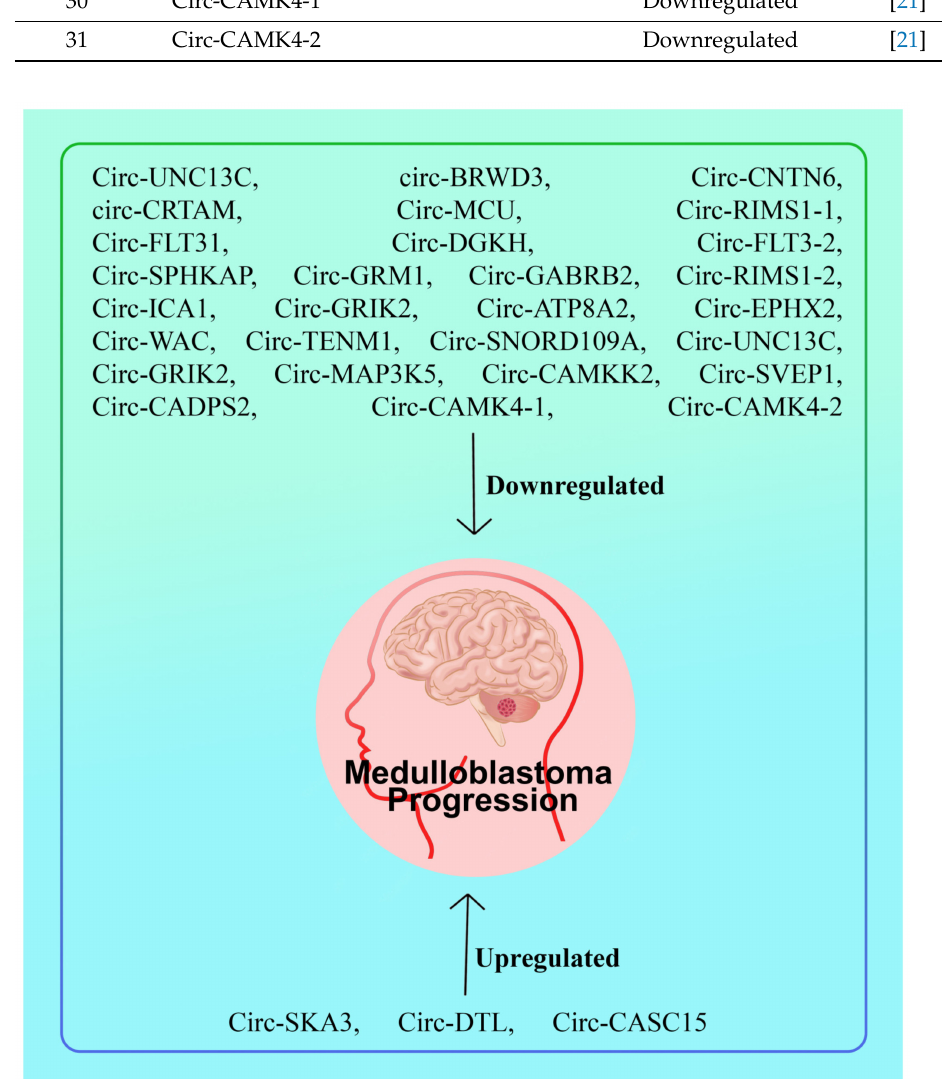
Figure 2. CircRNA regulation on medulloblastoma: various circRNAs including circ-UNC13C, circ- BRWD3, circ-CNTN6, circ-CRTAM, circ-MCU, circ-RIMS1-1, circ-FLT31, circ-DGKH, circ-FLT3-2, circ- SPHKAP, circ-GRM1, circ-GABRB2, circ-RIMS1-2, circ-ICA1, circ-GRIK2, circ-ATP8A2, circ-EPHX2, circ- WAC, circ-TENM1, circ-SNORD109A, circ-UNC13C, circ-GRIK2, circ-MAP3K5, circ-CAMKK2, circ-SVEP1, circ-CADPS2, circ-CAMK4-1, and circ-CAMK4-2 are responsible for the downregulation of medulloblastoma growth. Although, various circRNAs including circ-SKA3, circ-DTL, and circ- CASC15 are responsible for the up-regulation of medulloblastoma